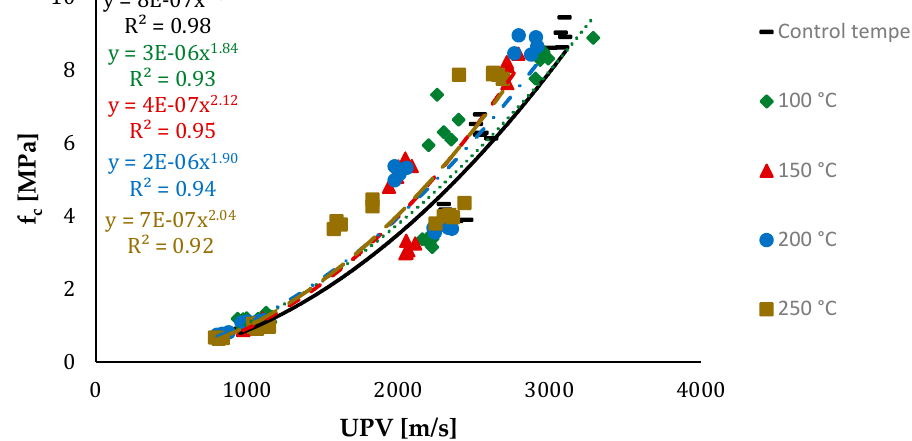
Figure 12. Relationship between ultrasound pulse velocity and compressive strength.